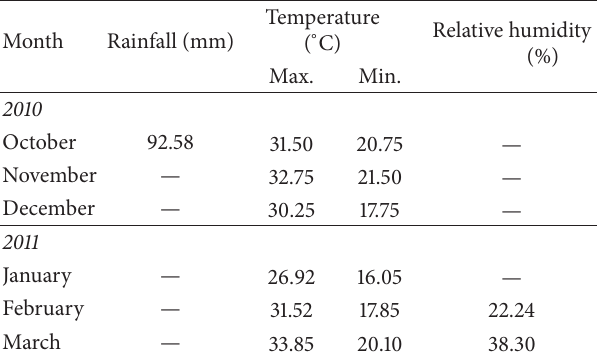
Table 5: Mean rainfall, maximum and minimum temperature, and relative humidity at monthly interval during the period of the experiment 2010/2011 dry